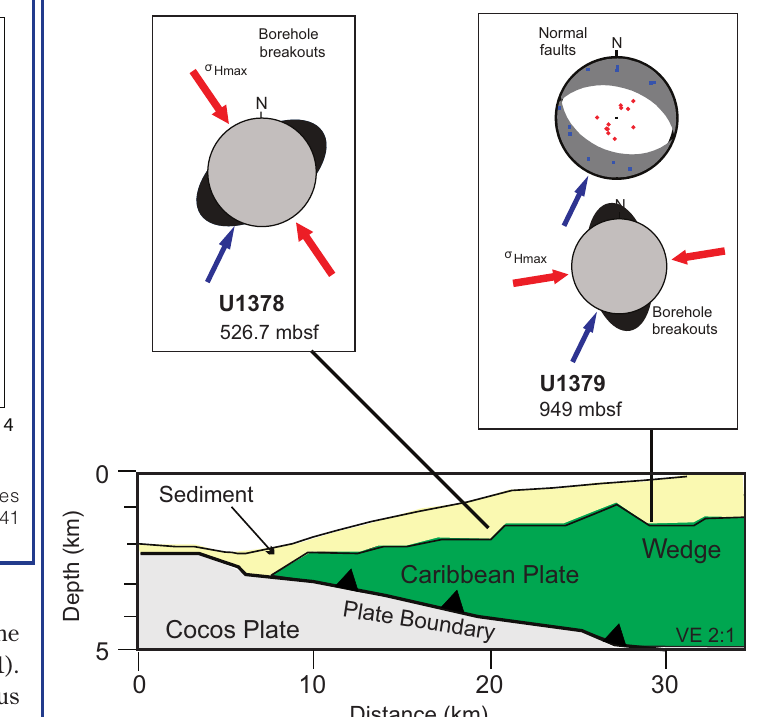
Figure 7. Summary of interpretations of borehole breakout for Sites U1378 and U1379 and of fault plane solution for Site U1379 fault data. Blue arrows represent the Cocos-Caribbean convergence direction. (VE=vertical